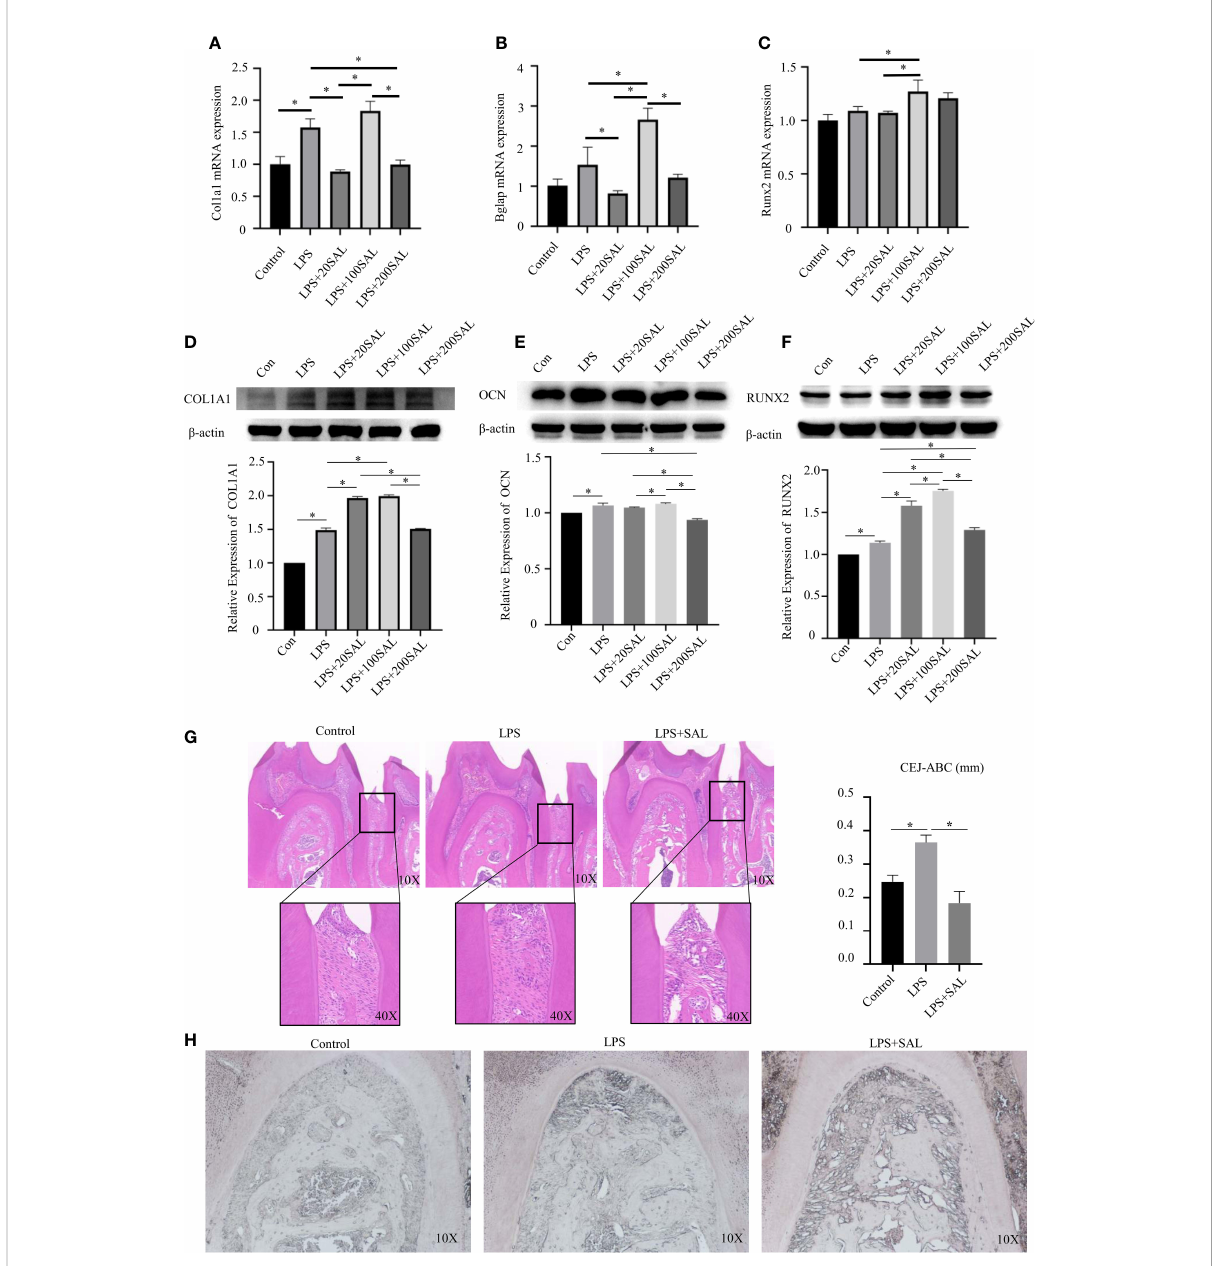
FIGURE 6 Effect of SAL on P. intermedia LPS-induced periodontitis in vivo and in vitro . (A-C) The mRNA expression of Runx2, Bglap, and Col1a1, respectively, in mBMSCs treated with P. intermedia LPS and different concentrations of SAL. (D-F) Representative western blots images and semi-quantitative analyses of the protein expression of COL1A1, OCN and RUNX2 in mBMSCs. (G) Representative H&E images of the periodontium after treatment with different drugs. (H) Representative images of ALP staining in the root bifurcation region *p <